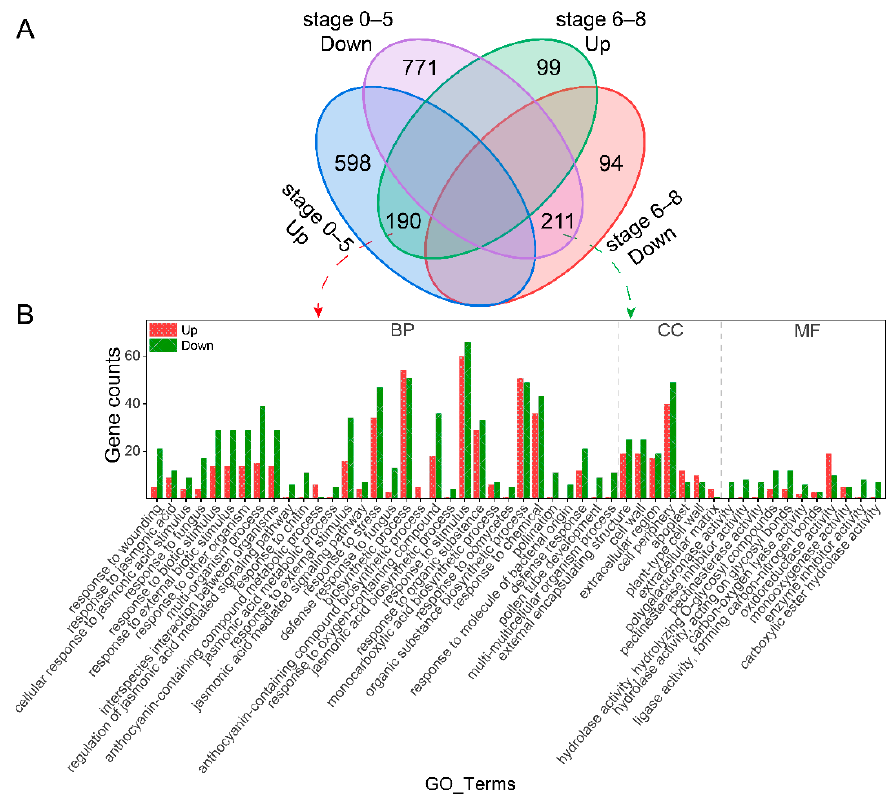
Figure 2. The analysis of DEGs. ( A ) Venn diagram of DEGs at stages 0–5 and 6–8 of flower develop- ment in inap CMS and H3; ( B ) GO annotation analysis of common DEGs at stages 0–5 and 6–8. Red and green bars represent up- and downregulated genes in inap CMS, respectively. BP, biological process. CC, cellular component. MF, molecular function.